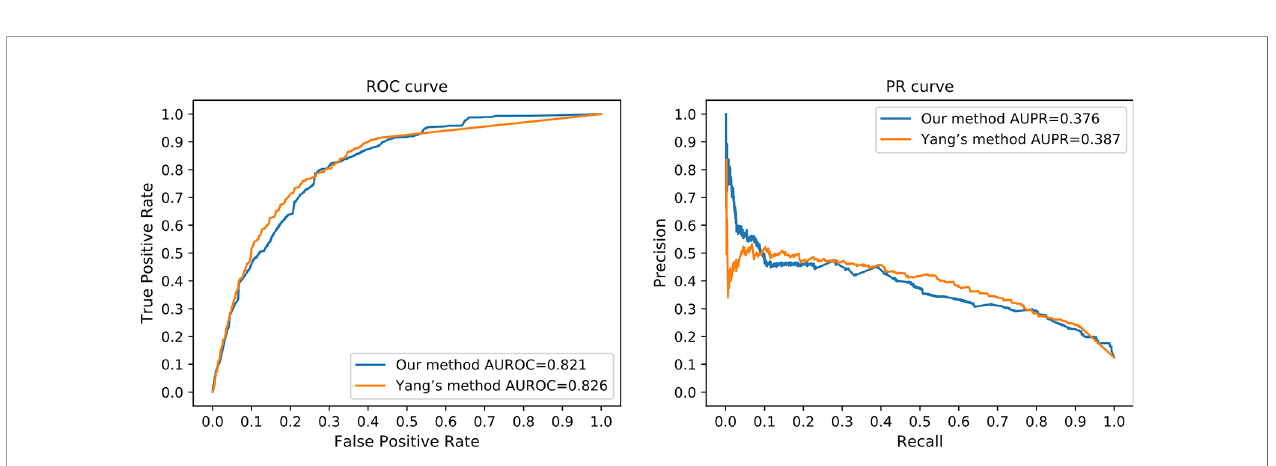
FIGURE 7 | The ROC curve and the PR curve of our method and Yang's